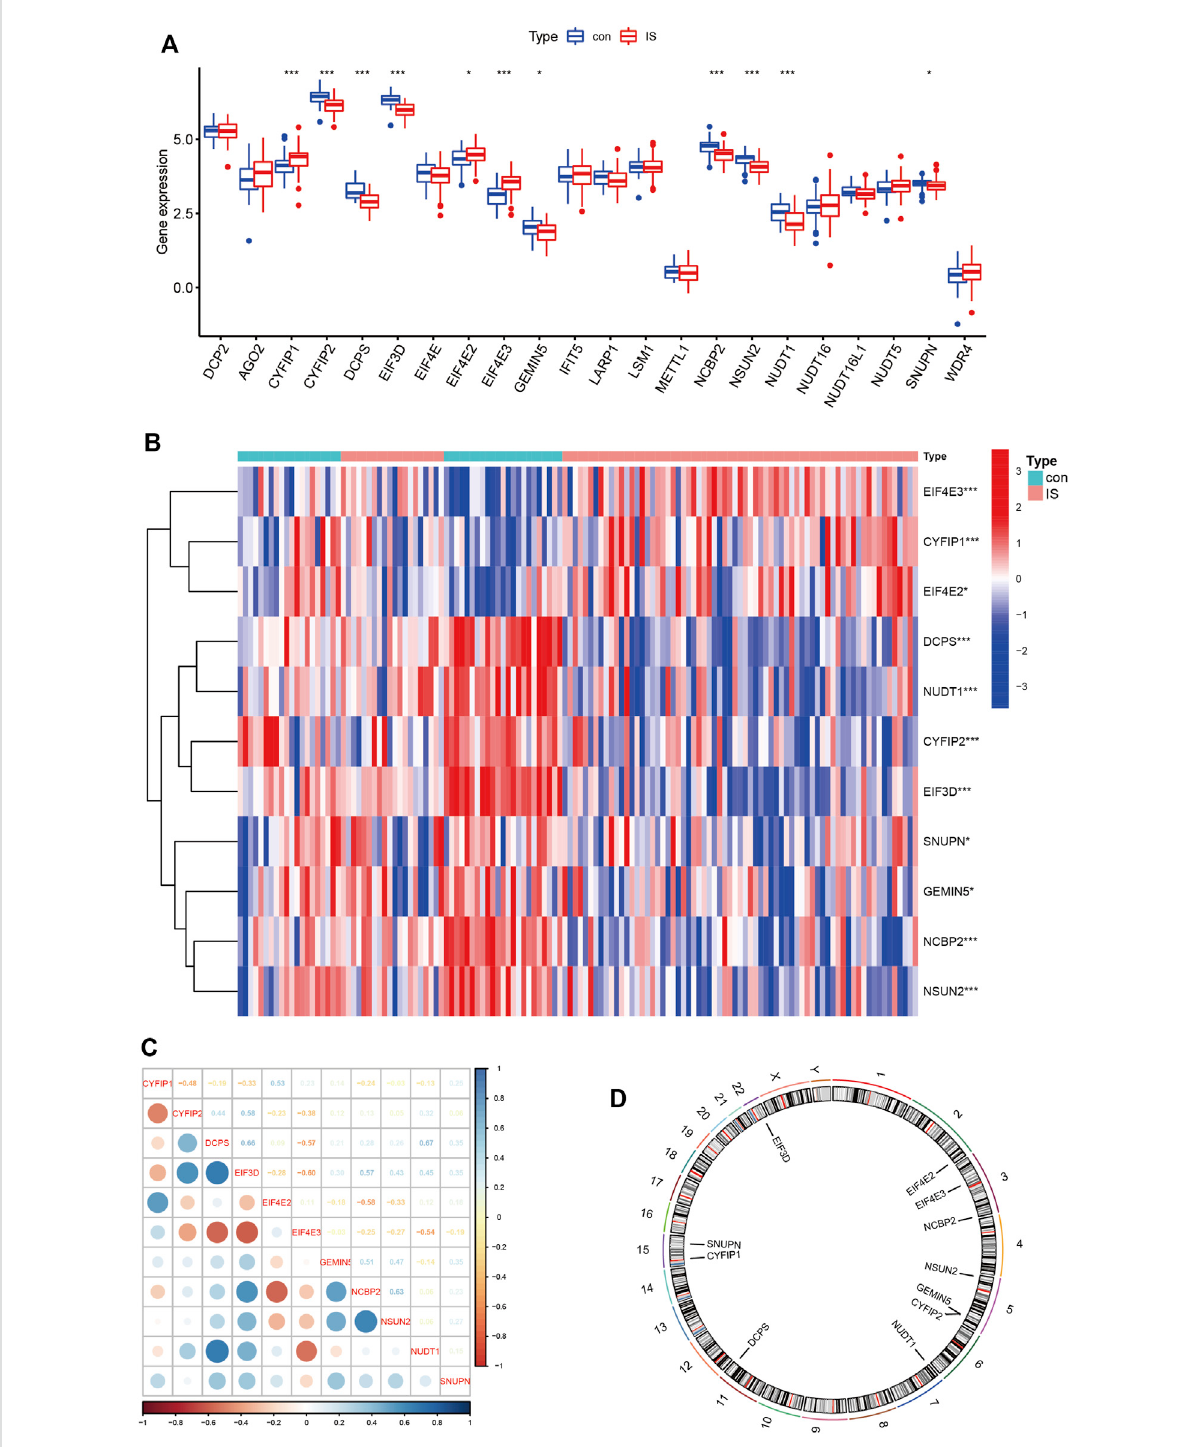
FIGURE 1 Expression patterns and differences of m7G-regulated genes in IS. (A) Boxplot of 34 m7G genes expression between control and IS. (B) Heatmap of 11 differentials expressed m7G genes between control and IS. Red represents high expression and blue represents low expression. (C) Correlations of m7G DEGs in IS. Blue represents positive correlation and red represents negative correlation. (D) Chromosomal positions of m7G DEGs. * p < 0.05, ** p < 0.01, *** p < 0.001. IS: ischemia stroke; con: control; DEGs: differentially expressed